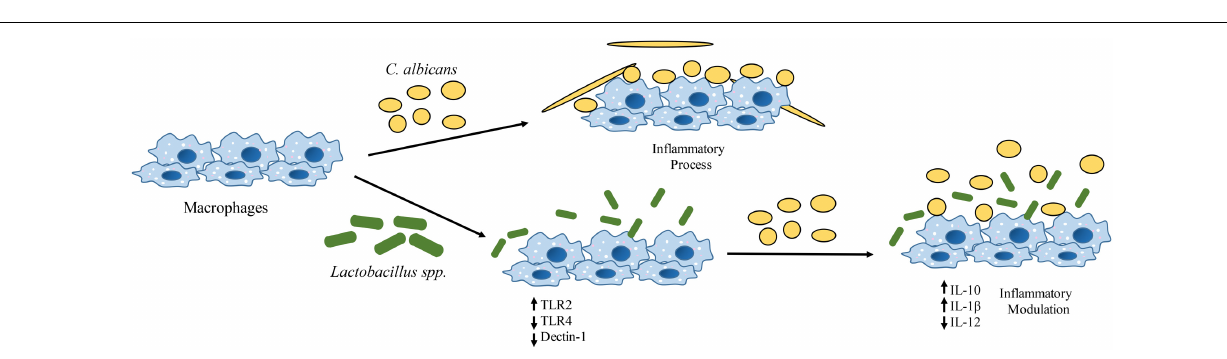
FIGURE 7 | Effects of Lactobacillus spp. on human macrophages challenged with C. albicans . There is an alteration in the transcription of pattern-recognition receptors (PRRs) genes ( CLEC7A , TLR2 , and TLR4 ) with a significant reduction of C. albicans receptors (dectin-1) on macrophages. These changes have an impact on the cytokine profile that leads to an anti-inflammatory